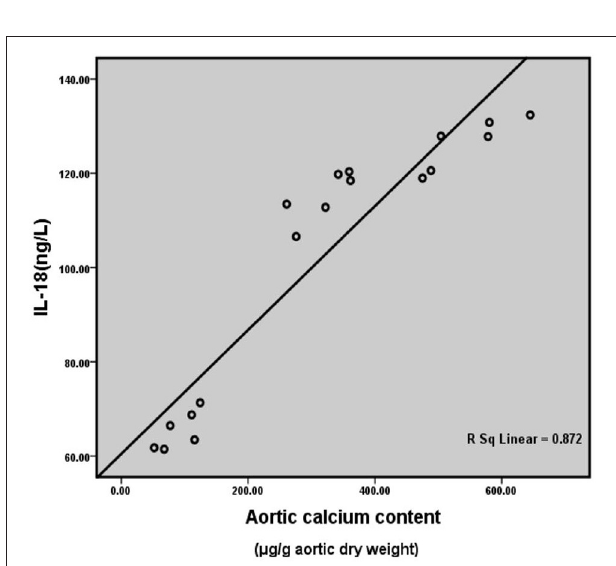
FIGURE 7 | Correlation analysis of rat serum IL-18 level and aortic calcification content. Six rats were included in each group.